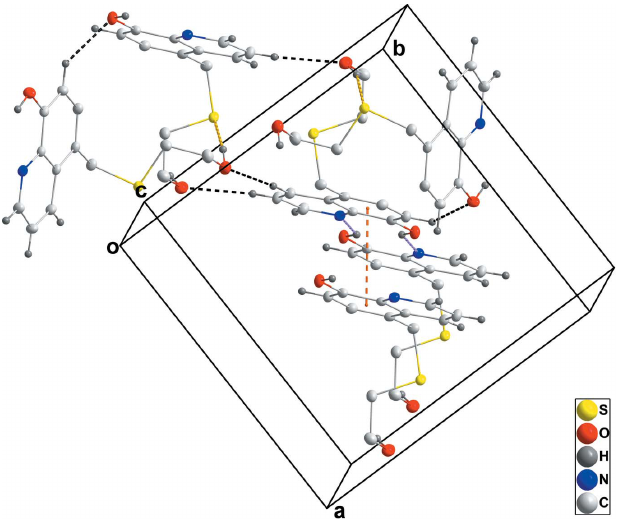
Figure 2 Detail of the intermolecular interactions. O—H (cid:2)(cid:2)(cid:2) N, C—H (cid:2)(cid:2)(cid:2) O and C— H (cid:2)(cid:2)(cid:2) S hydrogen bonds are shown, respectively, by light-purple, black and gold dashed lines. The (cid:2) -stacking interaction is shown by an orange dashed